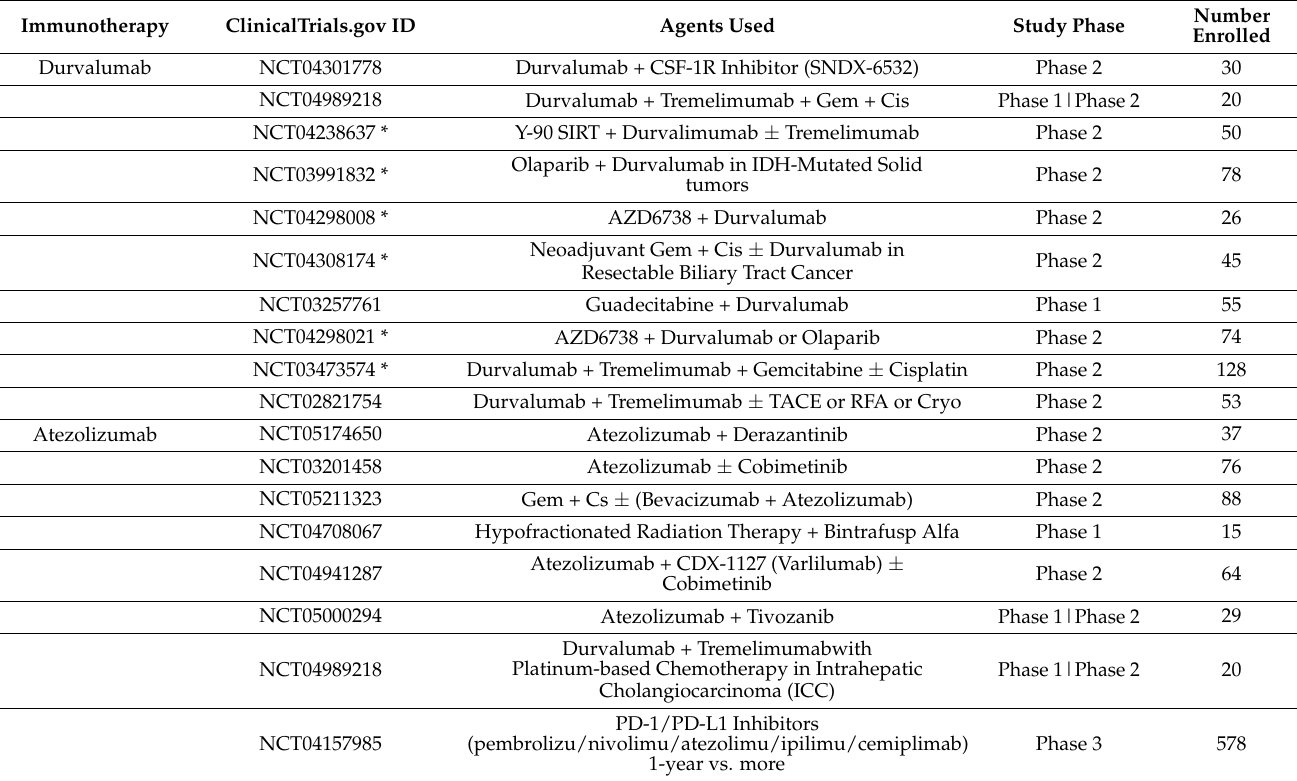
Table 4. Ongoing Immunotherapy-based Trials in